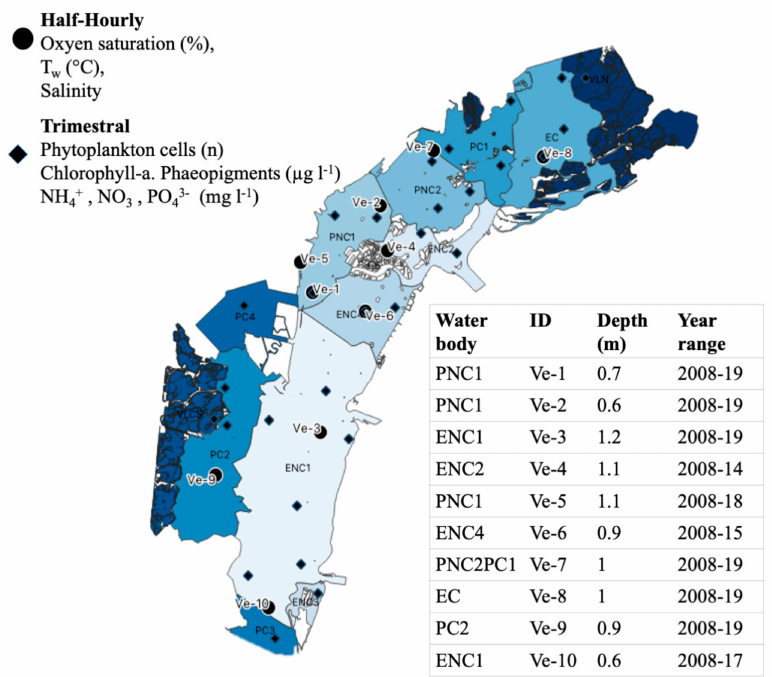
Figure 1. Map of the Venice lagoon with the water bodies represented and the buoy locations (circles), depth and year range. Diamonds represent sampling stations for nutrients and phytoplankton